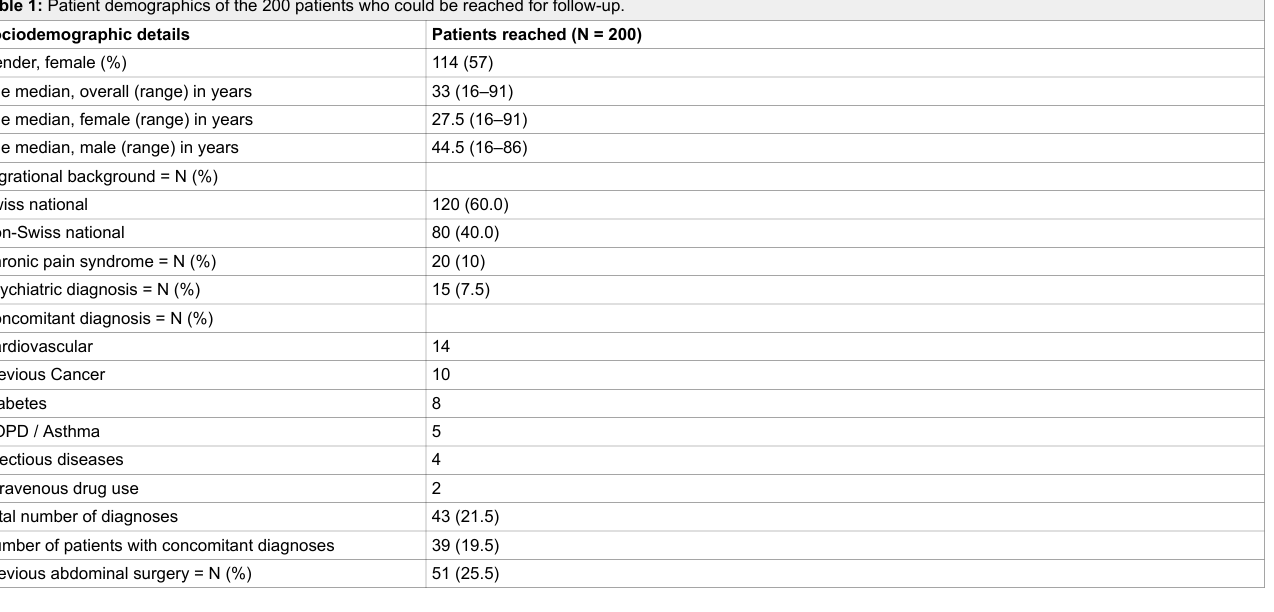
Table 2: Compares patient demographics between patients who suffered from persistent NSAP at the time point of the follow-up (N = 53) and those without NSAP (N = 147). Sociodemographic